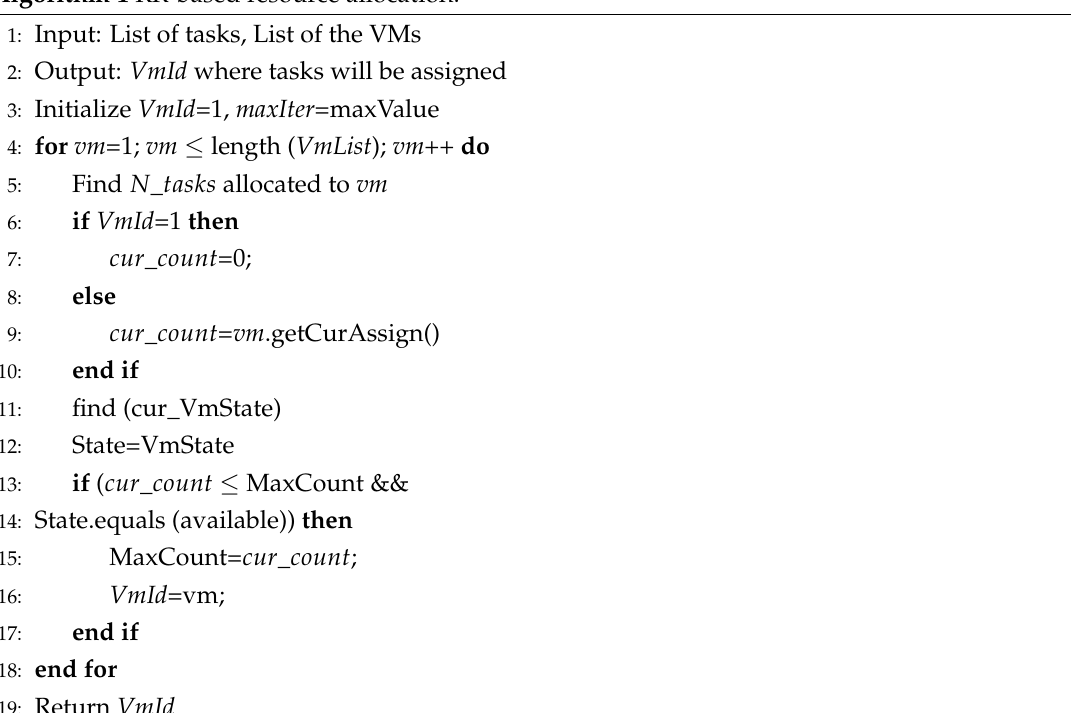
Algorithm 1 RR-based resource